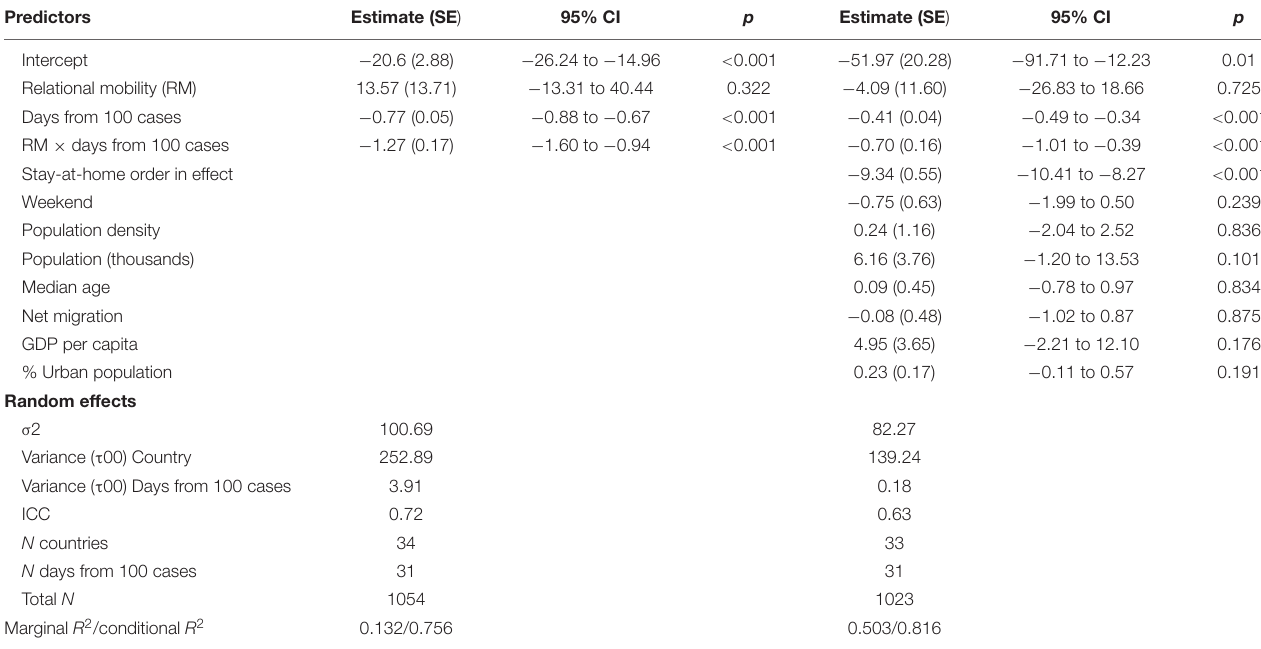
TABLE 4 | The impact of relational mobility on geographic mobility following the first 100 cases of COVID-19 in each country.